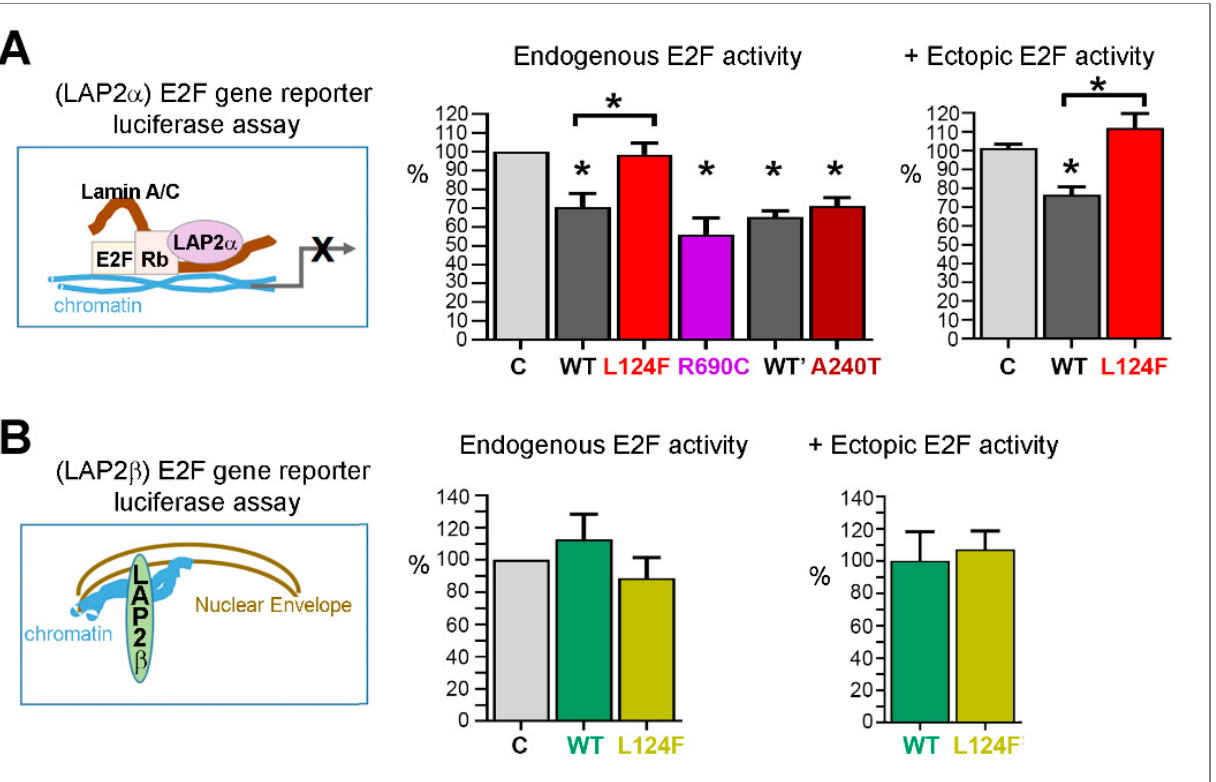
Figure 9. Impact of the p.(Leu124Phe) mutation on the capacity of LAP2s to inhibit E2F activity. Reporter E2F-luciferase activity driven by binding of WT or mutant (L124F, R690C A240T) LAP2 α DDK ( A ) and WT or mutant L124F LAP2 β -DDK ( B ) to E2F target sequences. LAP2-DDK proteins were expressed in the absence or presence of ectopic HA-E2F1 in HEK293 cells. Results are expressed in % activity versus cells co-expressing E2F-luciferase and an empty pcdna vector ( C ). N = 3 to 5 independent experiments. * p < 0.05 (Mann–Whitney test).